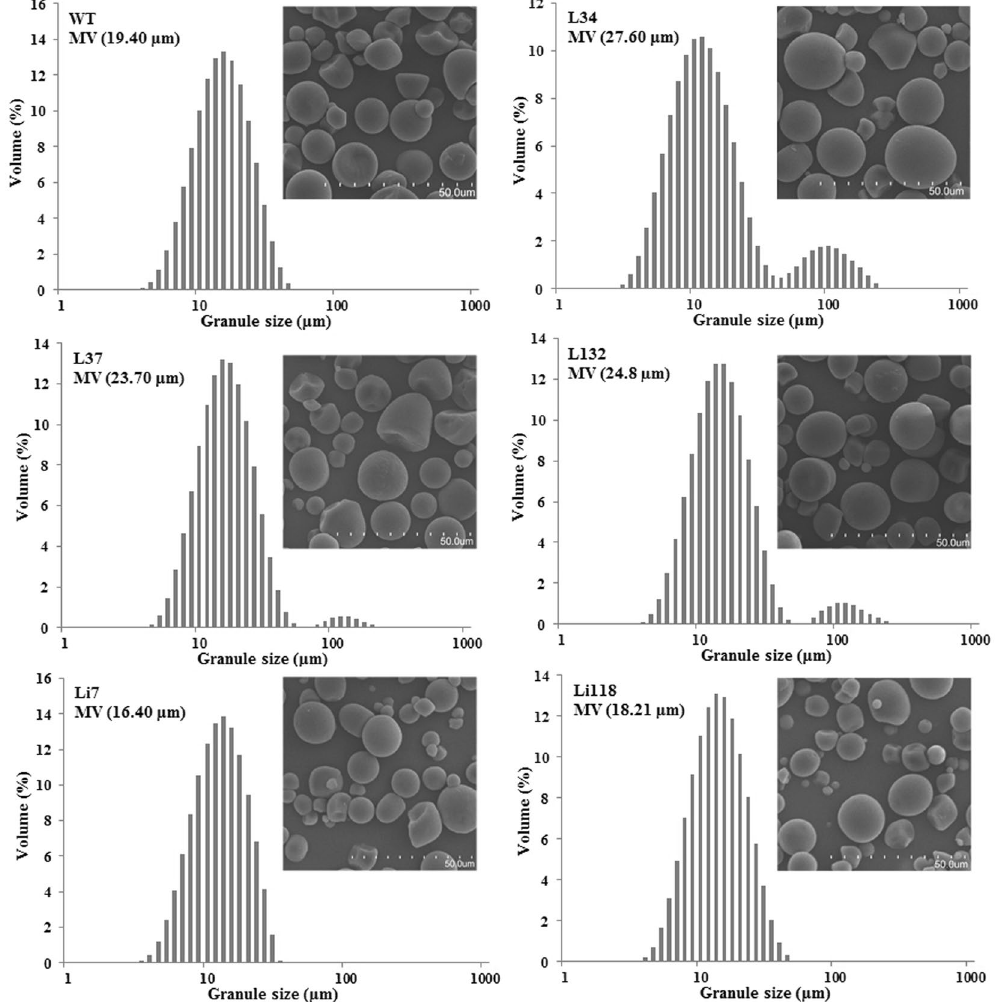
Figure 6. Size distribution and mean volume diameter (MV) of starch granules from the transgenic plants and WT. Insets: Scanning electron micrographs of the starch granules from the transgenic plants and WT. The dotted line indicates a length of 50.0 µ